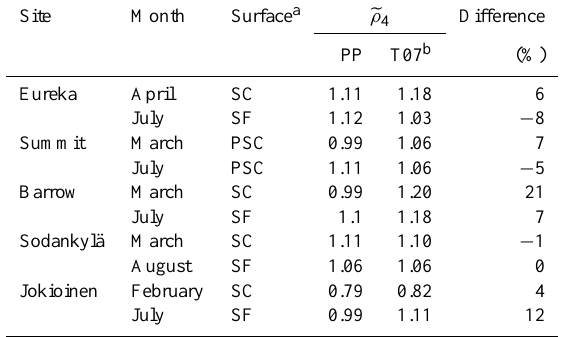
Table 3. Comparison of results from the present paper (PP) and those published by